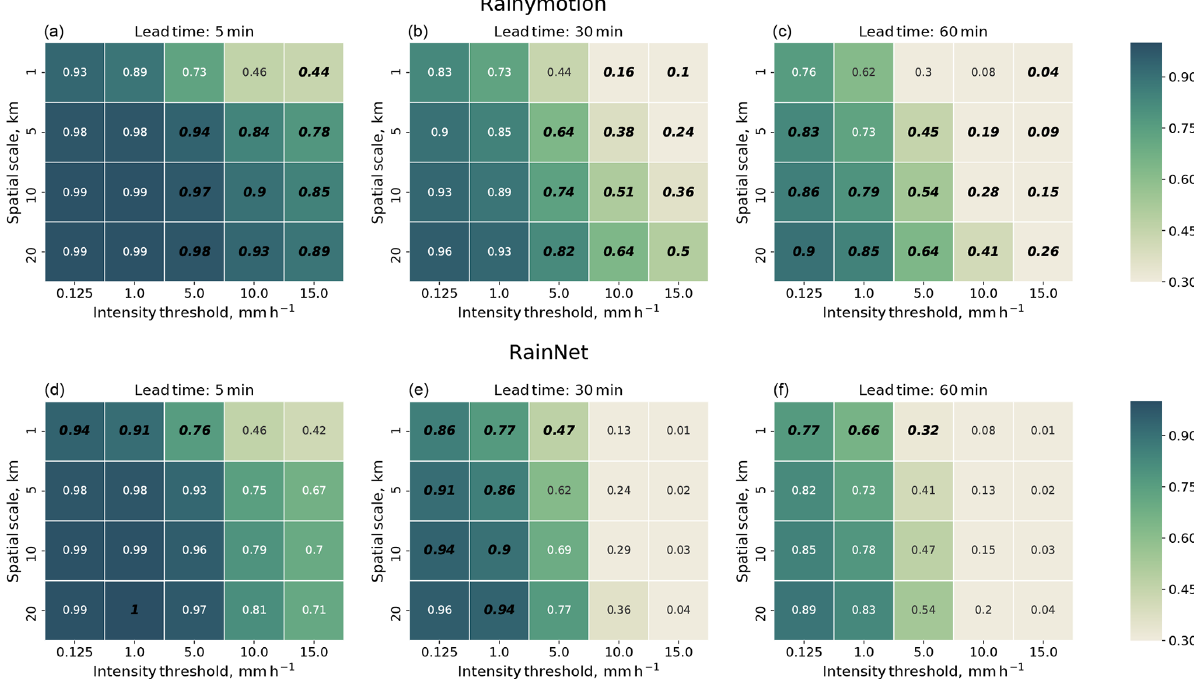
Figure 6. Fractions skill score (FSS) for Rainymotion (a, b, c) and RainNet (d, e, f) for 5, 30, and 60min lead times, for spatial window sizes of 1, 5, 10, and 20km, and for intensity thresholds of 0.125, 1, 5, 10, and 15mmh − 1 . In addition to the color code of the FSS, we added the numerical FSS values. The FSS values of the models which are significantly superior for a specific combination of window size, intensity threshold, and lead time are typed in bold black digits, and the inferior models are in regular